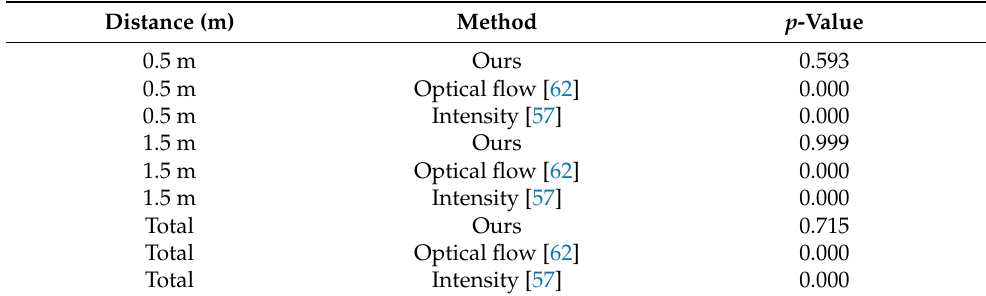
Table 8. Analysis of error statistics between estimation with motion noise and estimation without motion